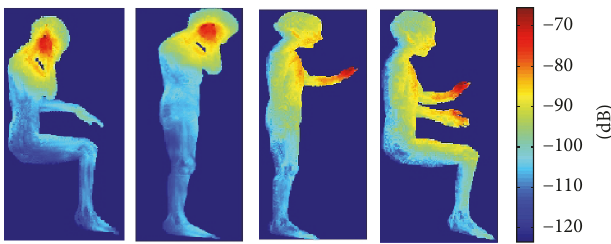
Figure 4: Distribution of the absorbed power (db) inside the numerical phantom for an input power of 1W.